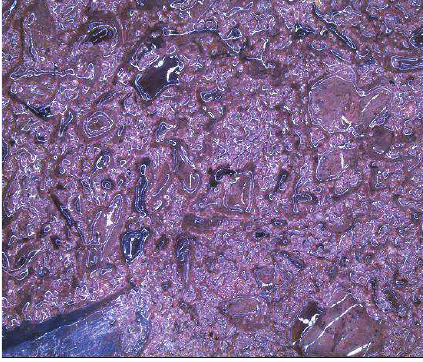
Figure 1: The electron microscope scanning image.